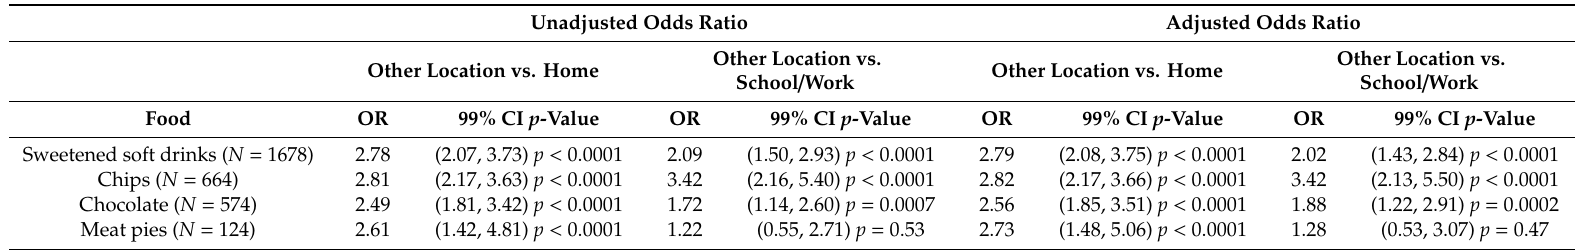
Table 5. Confirmatory odds ratio estimates based on the 2013–2016 NDNS-RP survey sample ( n = 1090 adolescents) [30] of eating sweetened soft drinks, chips, chocolate and meat pies in other locations versus at home or versus at school / work, unadjusted ORs and ORs fully adjusted by age (continuous), sex, day of the week (weekdays vs. weekend), socio-economic status (eight categories), BMI (continuous), ethnic group (white or non-white), smoking status (smoker or non-smoker) and alcohol status (drinker or non-drinker). Unadjusted Odds Ratio Adjusted Odds Ratio Other Location vs. Other Location vs. Home School /